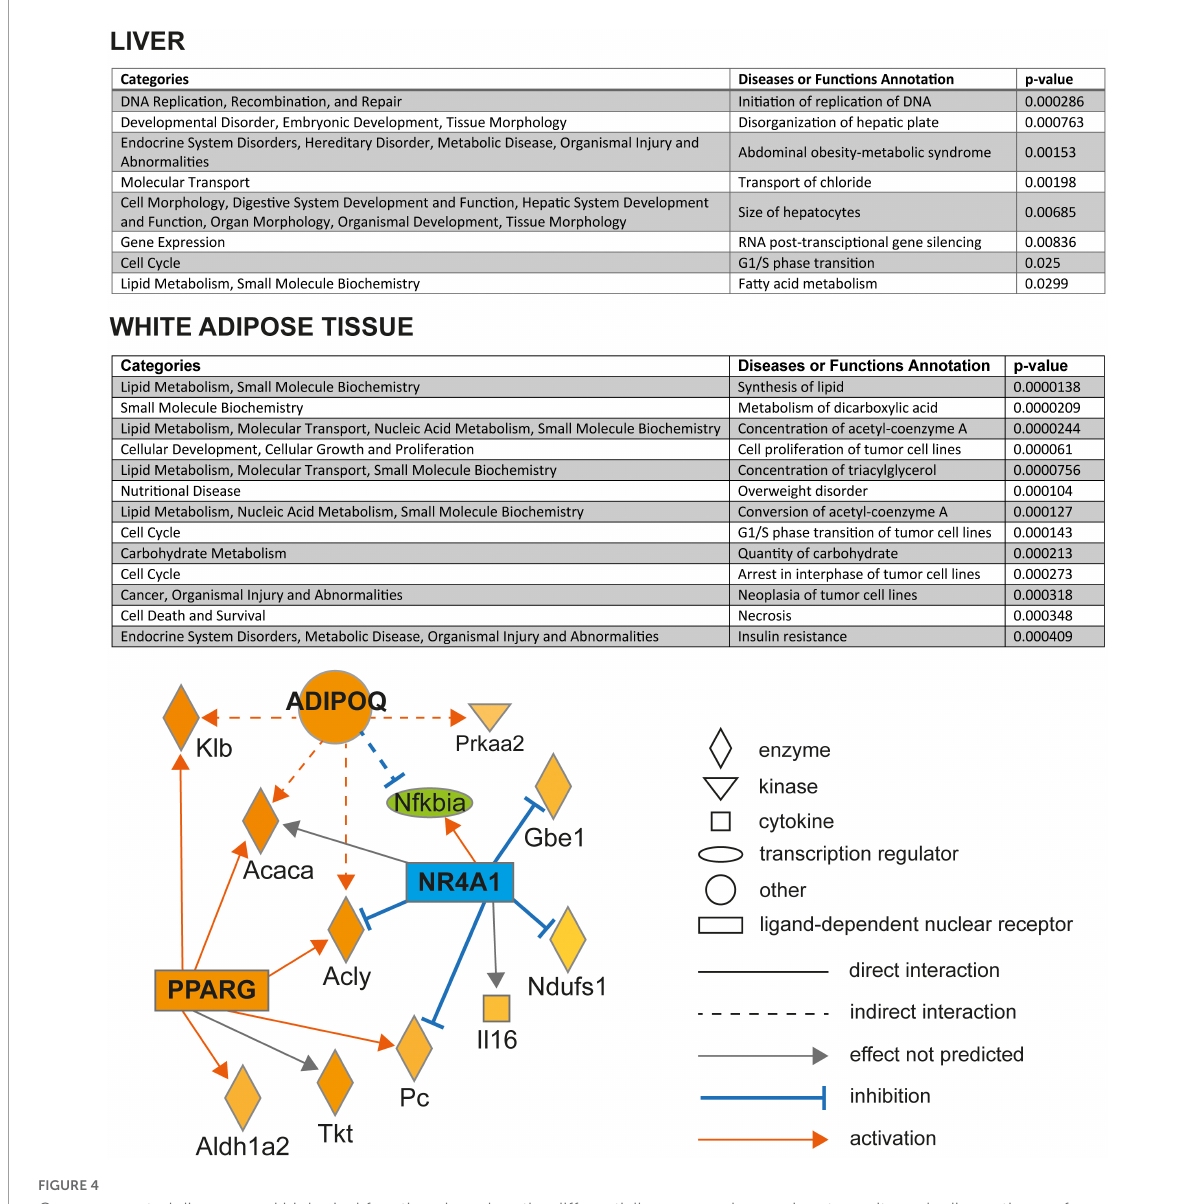
FIGURE4 Overrepresented diseases and biological functions based on the differentially expressed genes in retroperitoneal adipose tissue of quercetin-treated vs. control PD rats in liver ( top panel ) and retroperitoneal adipose tissue ( middle panel ). The p -values (Fisher’s exact test) reflect the overrepresentation of differentially expressed genes in the particular disease and biological functions sets. Bottom panel : Mechanistic network of predicted upstream regulators (ADIPOQ, NR4A1, and PPARG) based on the dataset of differentially expressed genes in retroperitoneal adipose tissue of control and quercetin-treated PD rats. The quercetin effect on the expression of genes significantly differentially expressed is shown in shades of green (downregulation, blue for the predicted state of upstream regulators) or red (upregulation). All above analyses were performed using Ingenuity Pathways